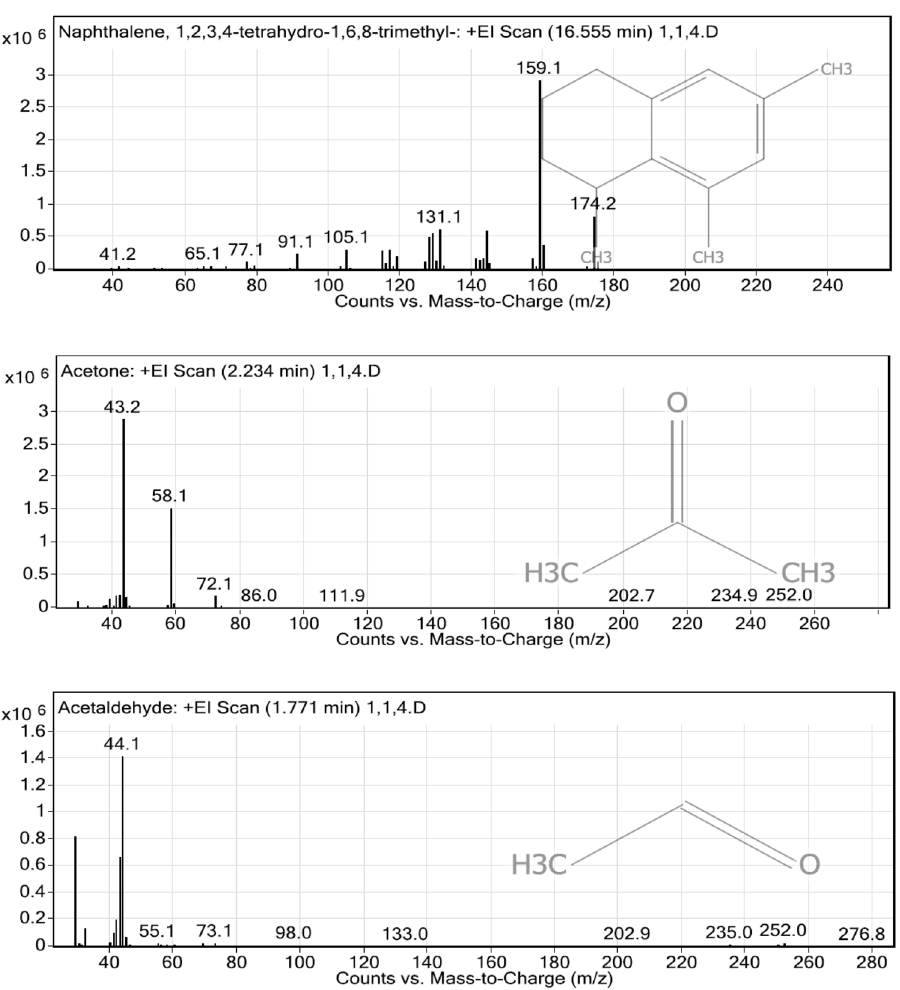
Figure 2. The most abundant volatile organic matters from the enzymatic hydrolysis of untreated rice straw